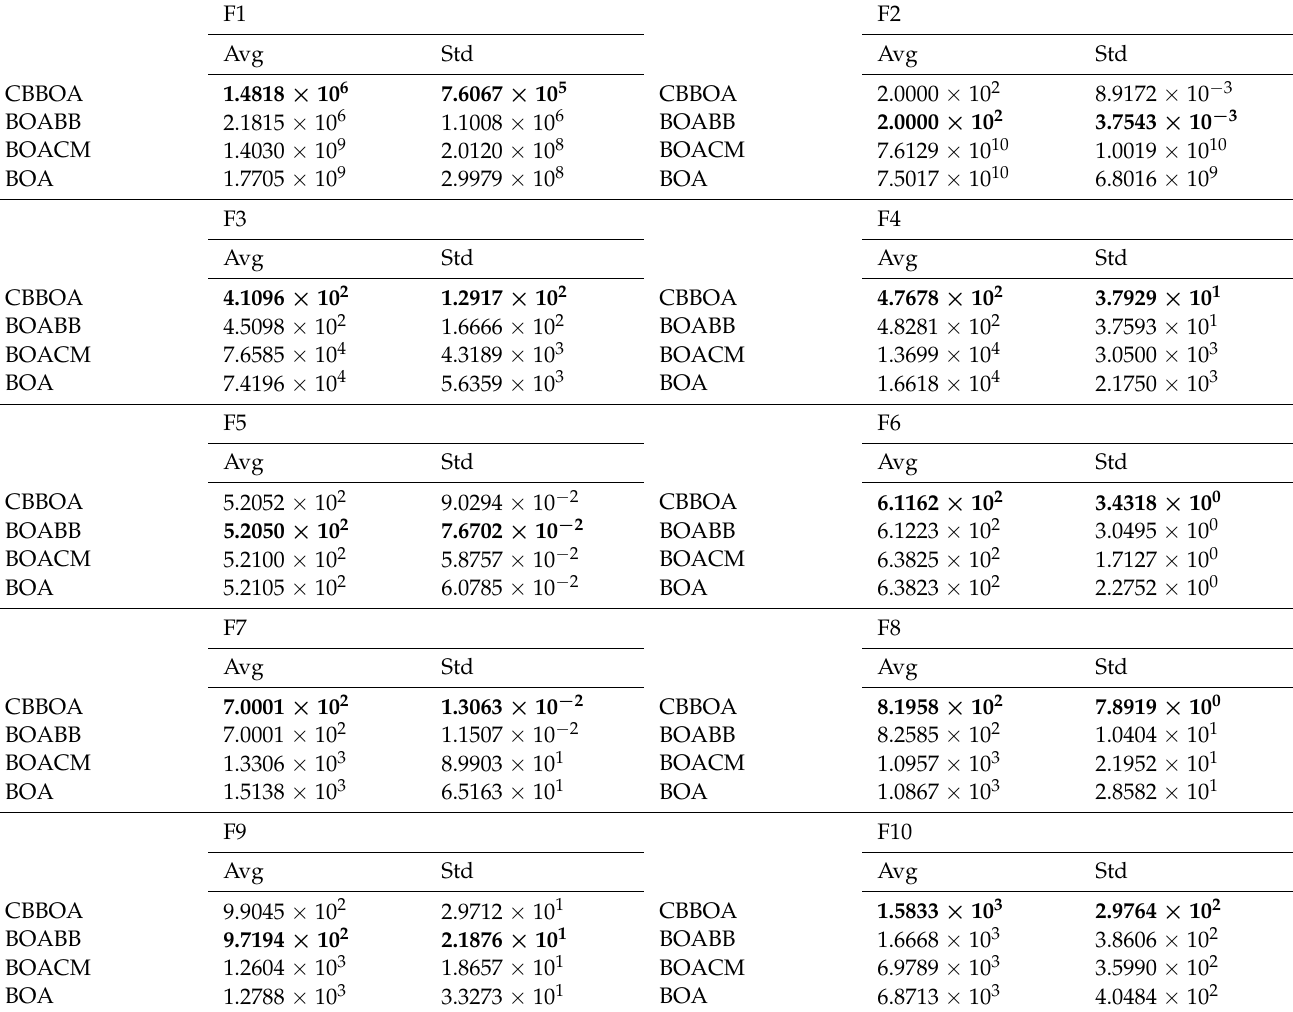
Table A4. Comparison results of CBBOA and other